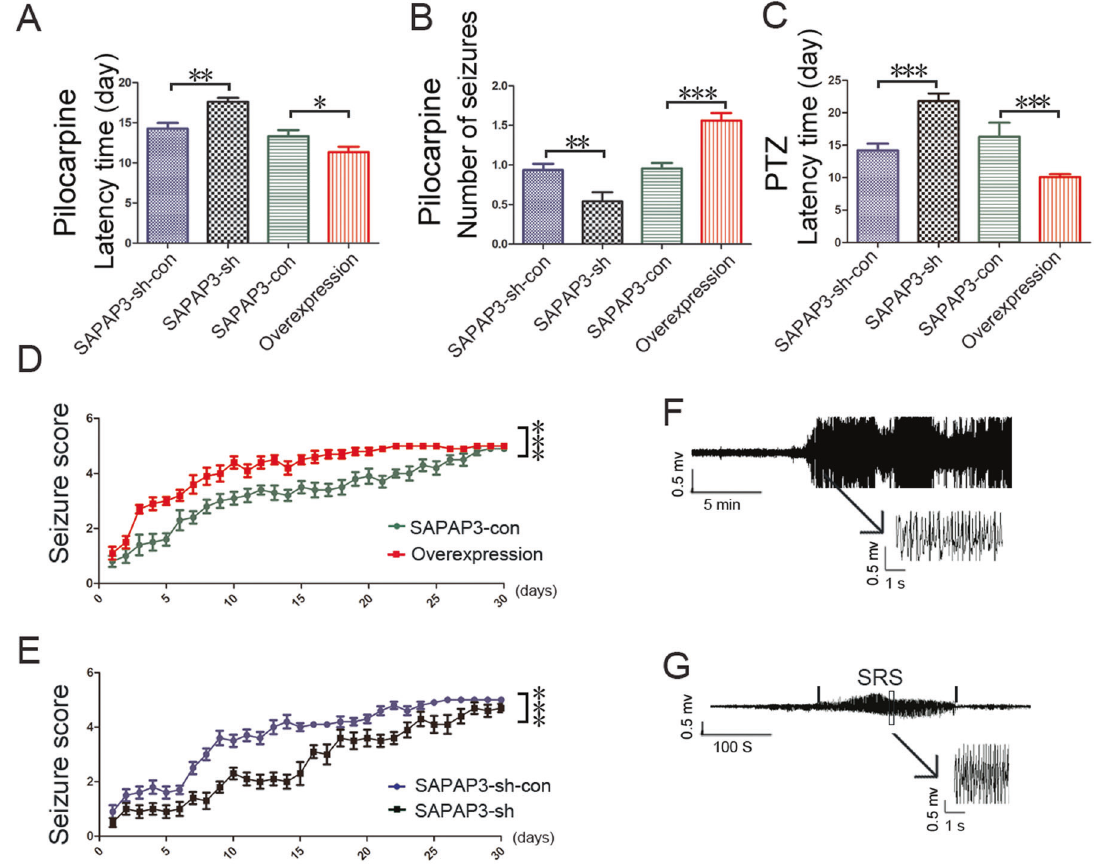
Fig. 3 Seizure-modifying effects of SAPAP3 on the pilocarpine-induced model and PTZ-kindling model. A SAPAP3-sh treatment signi fi cantly increased the latency time to the fi rst spontaneous seizures and B reduced the numbers of pilocarpine-induced spontaneous seizures in the chronic period. Recombinant SAPAP3 yielded the opposite results ( A , B) . Data are presented as means ± SEM, n = 8 – 10. * p < 0.05; ** p < 0.01; *** p < 0.001. C SAPAP3-sh treatment signi fi cantly increased the latency time in the pentylenetetrazol-induced kindling model and E reduced the severity of pentylenetetrazol-induced seizures. Recombinant SAPAP3 yielded the opposite results ( C , D ). Data are presented as means ± SEM, n = 10. *** p < 0.001. F Representative EEG recording of pilocarpine-induced status epilepticus. G Typical EEG showing that mice with spontaneous recurrent seizures exhibited epileptic